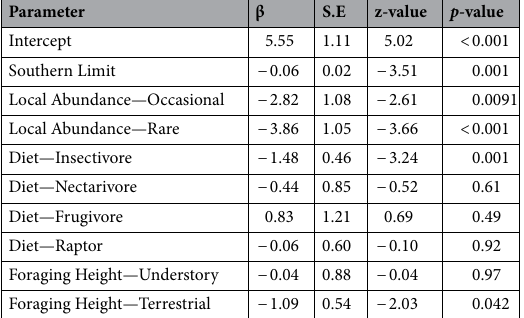
Table 1. Results from logistic regression of local bird extinctions from BCI as a function of local historical abundance, diet category, foraging height, and southernmost Panama Canal range